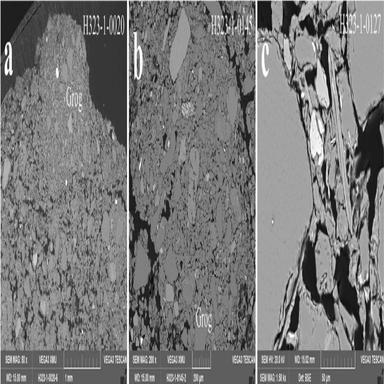
The BSE micrographs of the mould samples with Texture C.